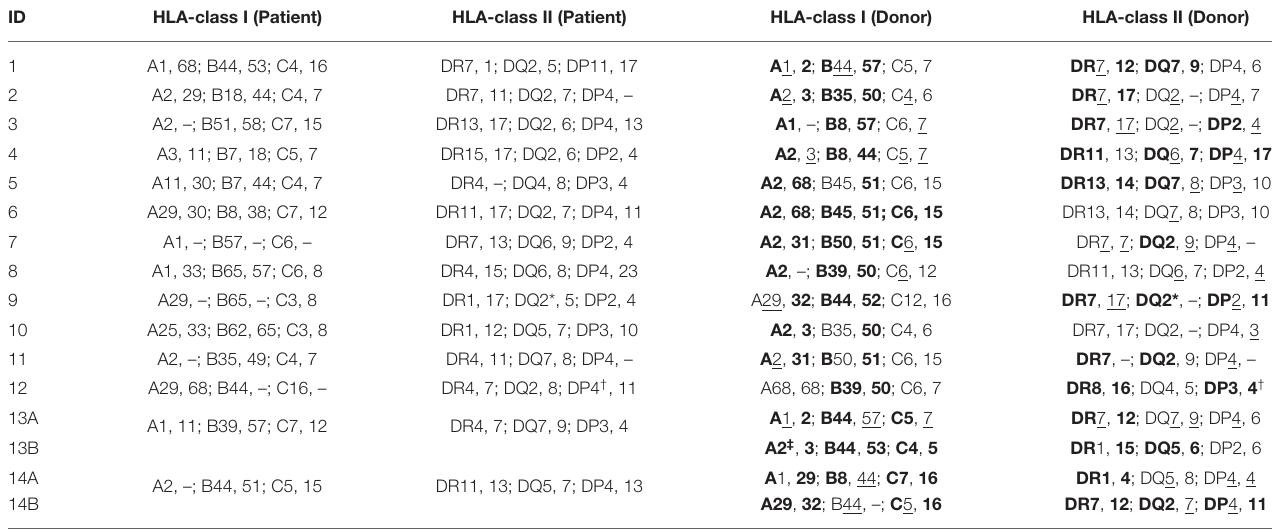
TABLE 4 | HLA phenotypes and DSA production.